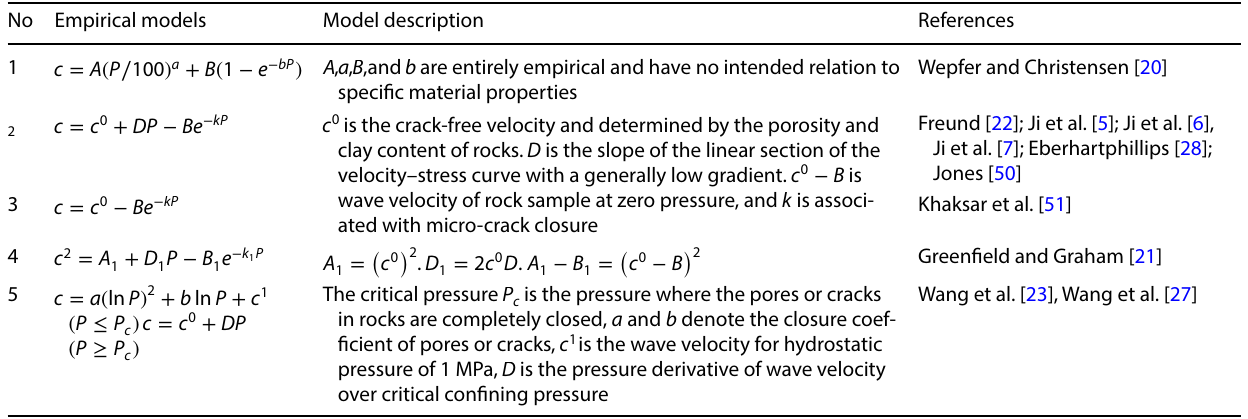
Table 1 Frequently-used empirical models for rock acoustoelasticity No Empirical models Model